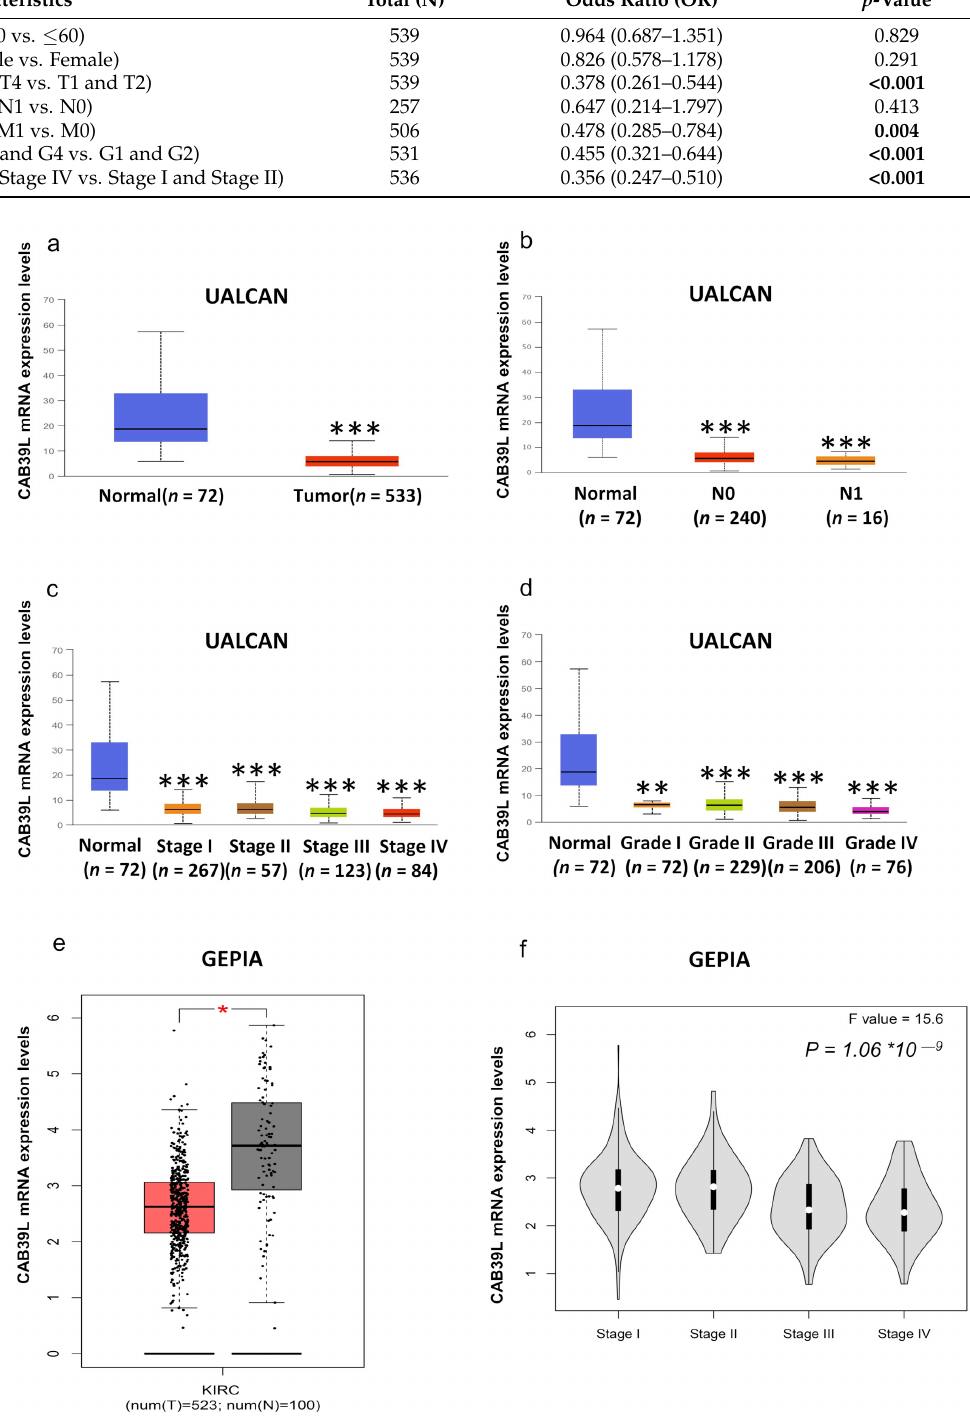
Figure 3. Analysis of the transcriptional level of CAB39L and its association with clinical parameters of KIRC patients (UALCAN and GEPIA). ( a ) mRNA expression of CAB39L in 533 KIRC samples and 72 normal tissue samples (UALCAN). ( b – d ) Relationship between the transcriptional level of CAB39L and N stage, pathologic stage, and histologic grade (UALCAN). ( e ) The transcriptional level of CAB39L in 523 KIRC samples and 100 normal tissue samples (GEPIA). ( f ) Relationship between the transcriptional level of CAB39L and pathologic stage (GEPIA). * p < 0.05, ** p < 0.01, *** p < 0.001.